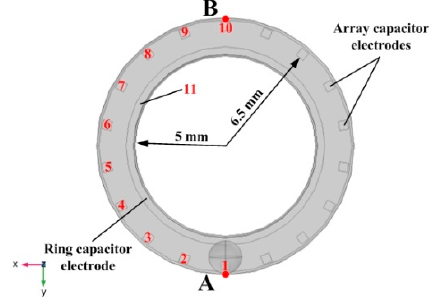
Figure 7. The capacitor electrodes of the sensor.